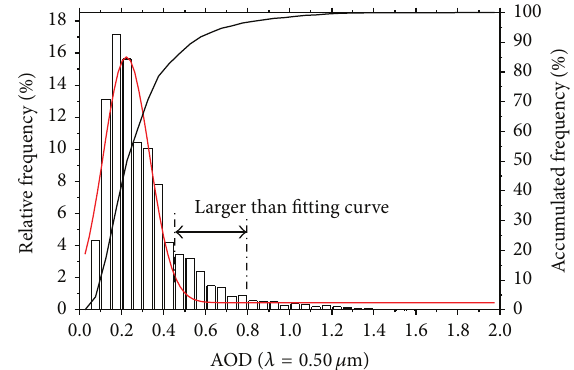
Figure 2: The histogram of AOD at 0.50 𝜇 m in the form of relative frequency and accumulated frequency.